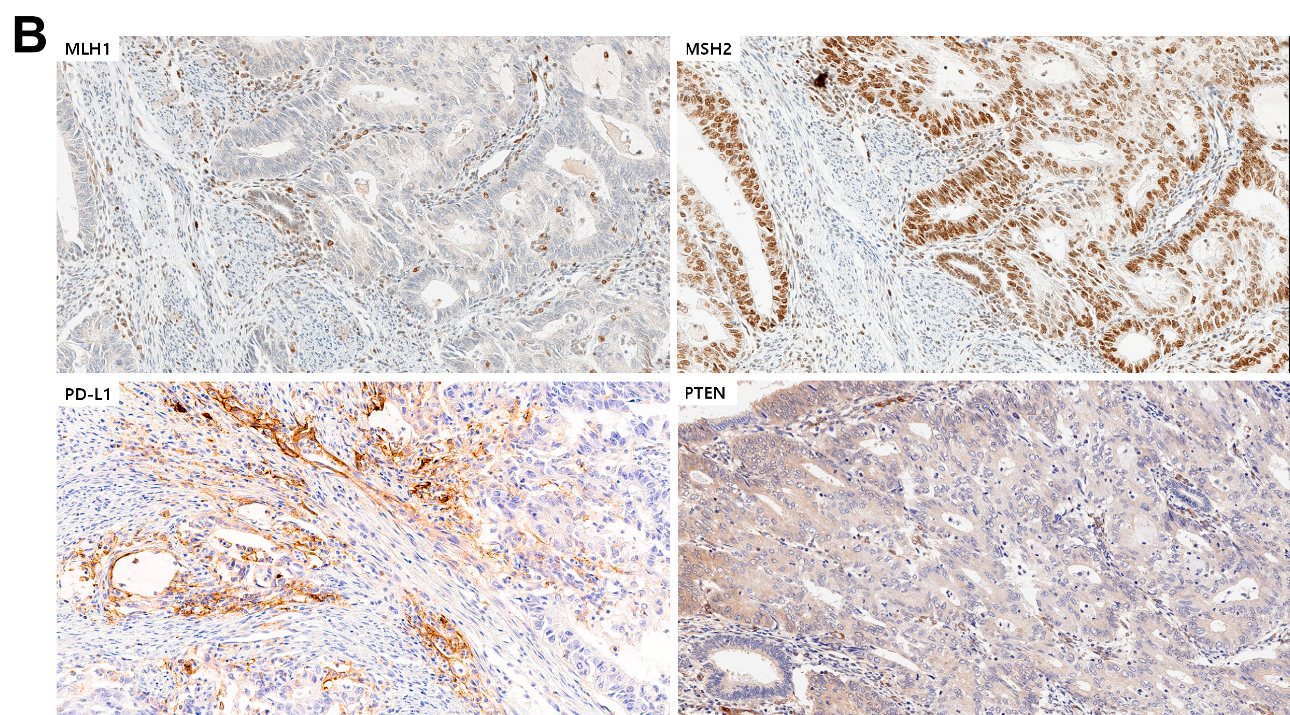
Figure 1. ( A ) In BAT26- only instability cancer, a mononucleotide ( A ) repeat was deleted by erroneous replication from the 3 ′ region of MSH2 exon 5 on chromosome 2. Amplification profile from case #01 using pentaplex PCR showing a BAT26- only unstable phenotype in tumor tissue. ( B ) Immunohistochemistry of tumor section from case #01 using antibodies targeting MLH1 and MSH2, showing the expression of mismatch repair proteins in tumor cells (partial mismatch repair deficiency), PD-L1 expression in lymphocytes (immune-excluded tumor microenvironment; CPS = 8), and PTEN protein loss in tumor sections. All images are at 2.0× magnification.